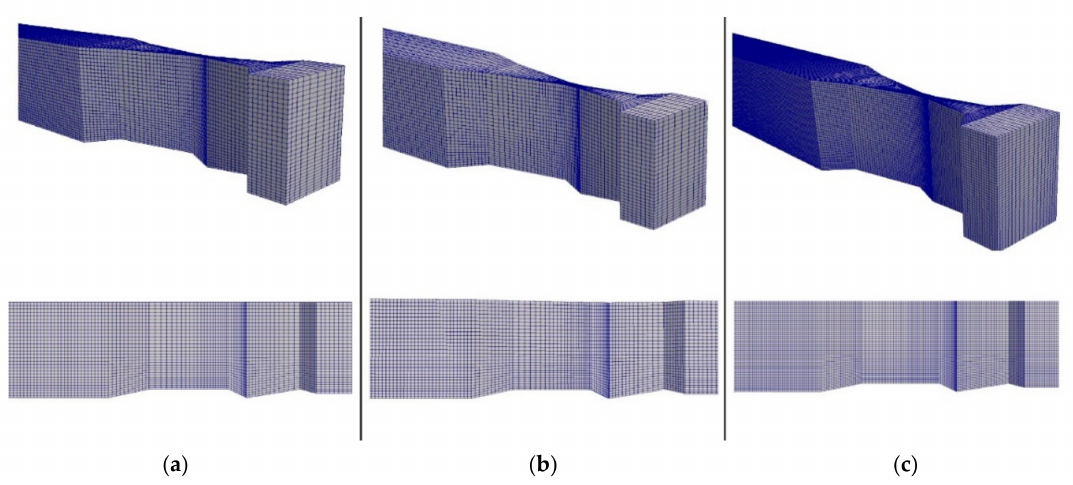
Figure 2. Mesh convergence analysis. Side view and 3D views of the Parshall flume mesh: ( a ) the mesh with a total of 52,200 cells; ( b ) the mesh with a total of 74,496 cells; ( c ) the mesh grid with a total of 263,700 cells.